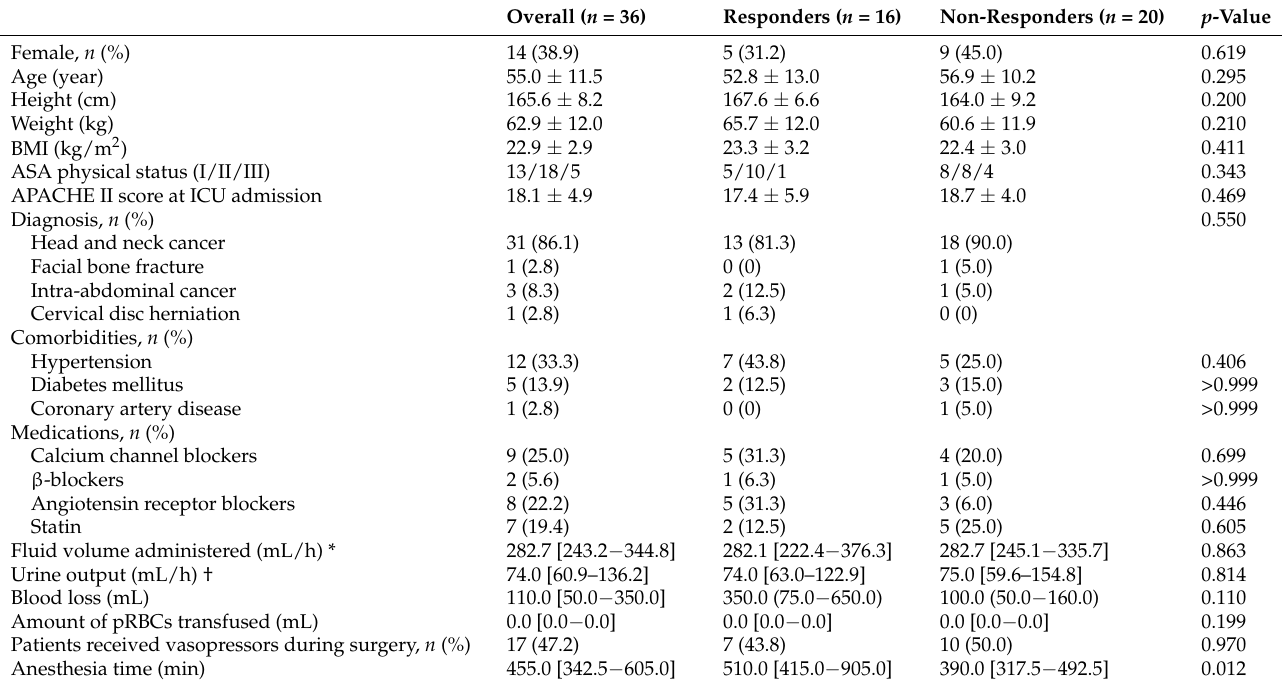
Table 1. Patient characteristics and details of